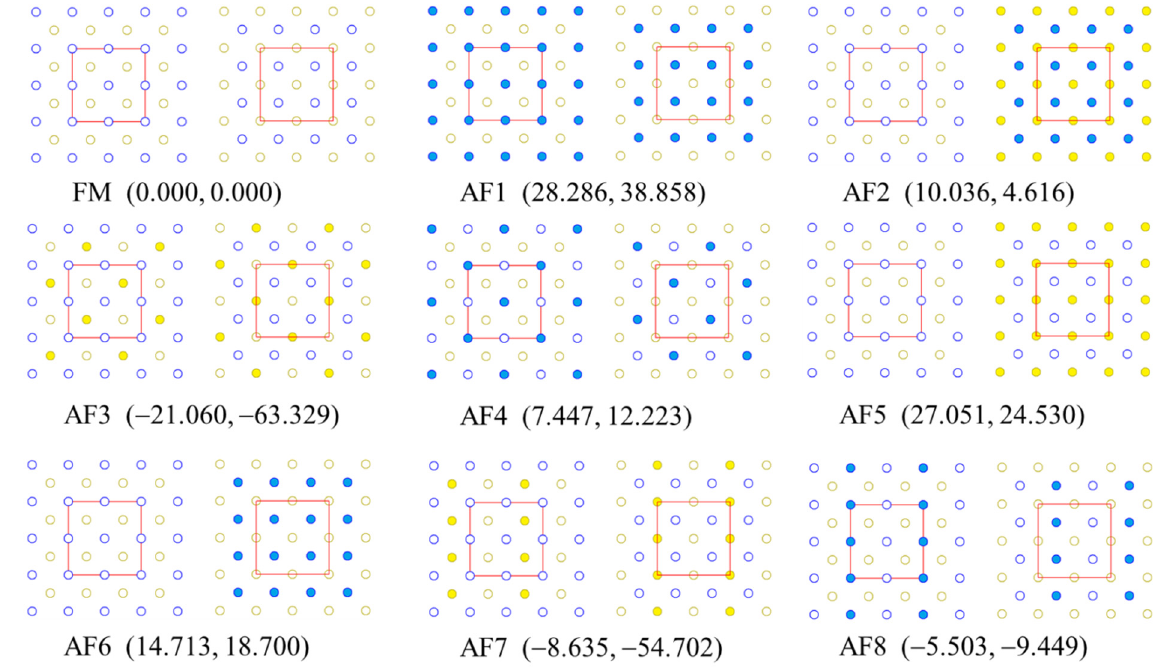
Figure 4. Spin arrangements in the FM and AF1–AF8 states of Ba 2 CuOsO 6 to evaluate the J 1 –J 8 values where the filled yellow, empty yellow, filled blue, and empty blue circles refer to spin-up Os 6+ , and spin-down Os 6+ , spin-up Cu 2+ , and spin-down Cu 2+ sites, respectively. In each state, the two //ab layers with the given ordered spin arrangements alternate along the c direction. The numbers in the parentheses refers to the relative energies associated with their FM state (in meV/FU), which was obtained from the DFT + U + SOC calculations with U Cu = 2, U Os = 3 eV and U Cu = 4, U Os = 5 eV. Table 2. Values of the spin exchanges J 1 –J 8 (in k B K) of Ba 2 CuOsO 6 obtained from the DFT + U + SOC calculations with U Cu = 2, U Os = 3 eV and U Cu = 4, U Os = 5 eV.